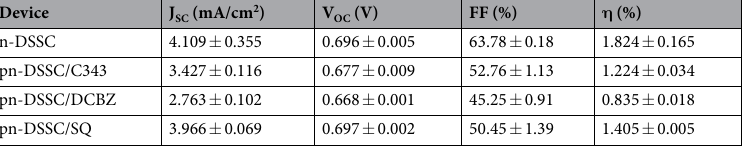
Table 2. Photovoltaic performance of 3 cells of each type of n-DSSC and pn-DSSCs (along with their standard deviations) illuminated through n-side under AM 1.5 G conditions based on DCA10CN2, C343, DCBZ, and SQ dyes using Co + 2/ + 3